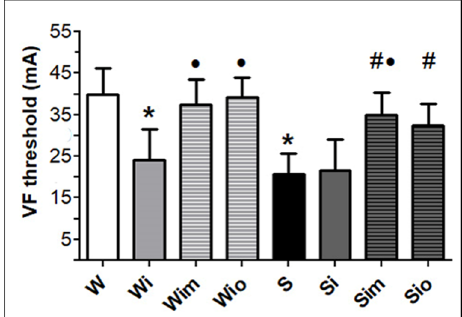
Figure 2. The threshold to induce persistent VF was lower in spontaneously hypertensive rat hearts (S) compared to Wistar rat (W) heart and reduced in W rats in response to ISO (Wi) while not in S. Treatment of ISO exposed rats with either melatonin (Wim, Sim) or omega-3 resulted (Wio, Sio) in a significant increase of VF threshold in both strains. Values are the mean ± SD of 6 rats in each group. * p <